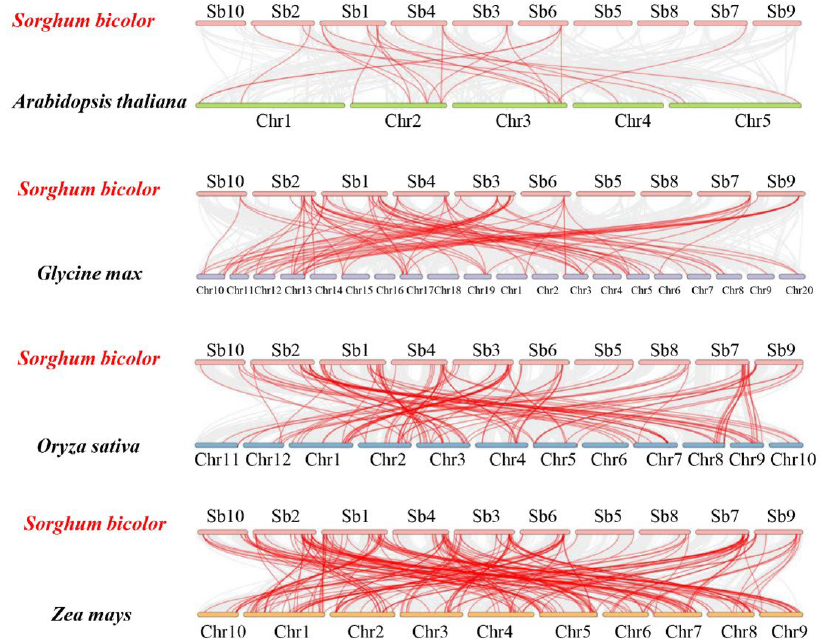
Figure 5. Synteny analyses of C2H2-ZFP genes between S. bicolor and four representative species. Gray lines represent the collinear regions within S. bicolor and other genomes, and red lines